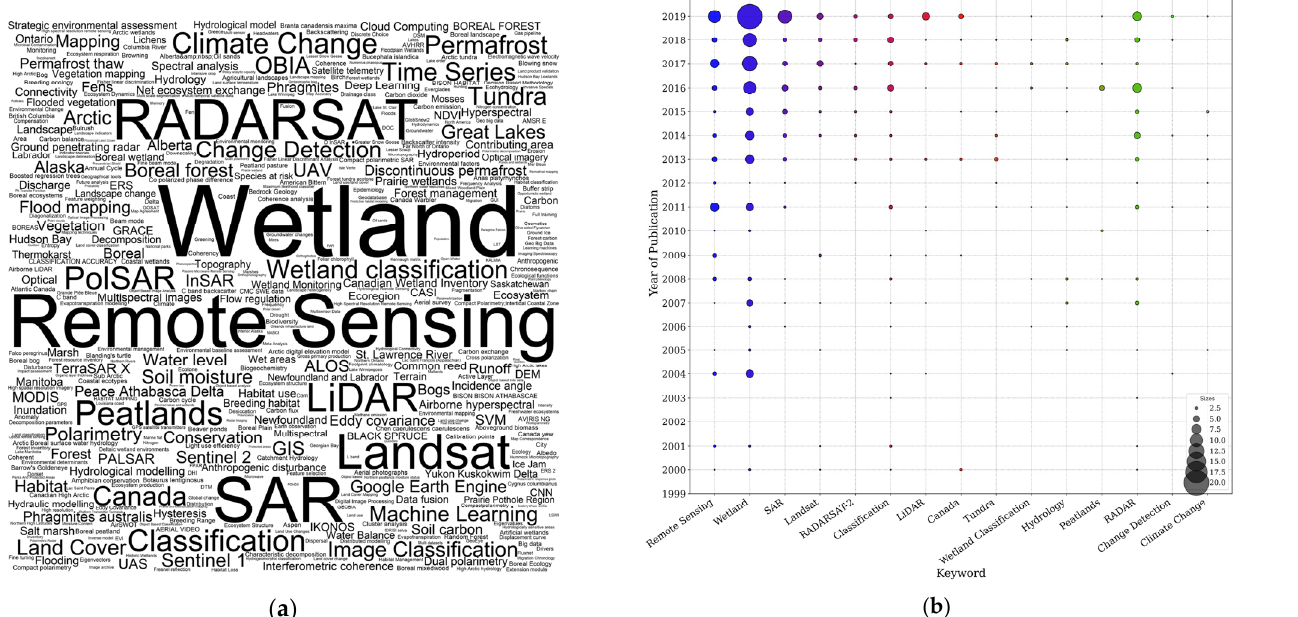
Figure 5. ( a ): Keyword frequencies of all the reviewed papers about RS-based wetland studies and ( b ): how many times a keyword has been repeated through the years.